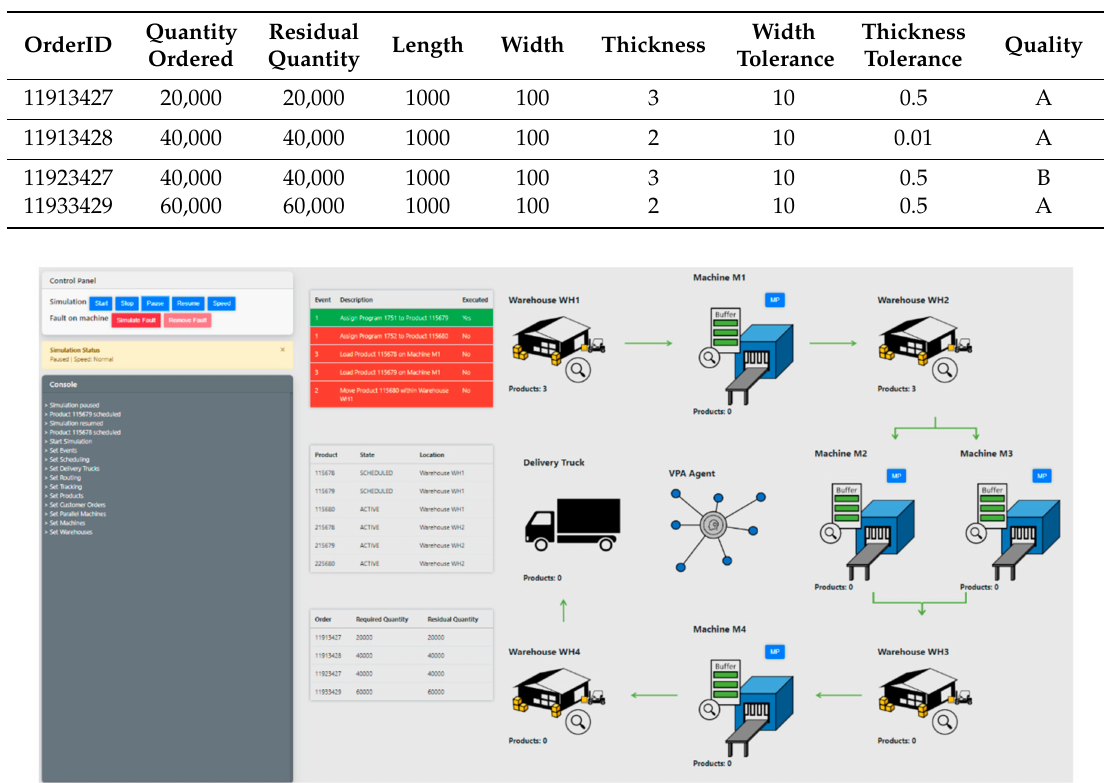
Figure 15. Customer reallocation scenario